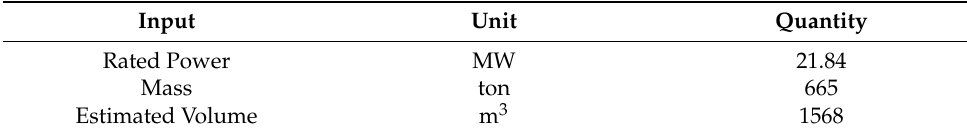
Table 2. MAN B&W 6G70ME-C engine data